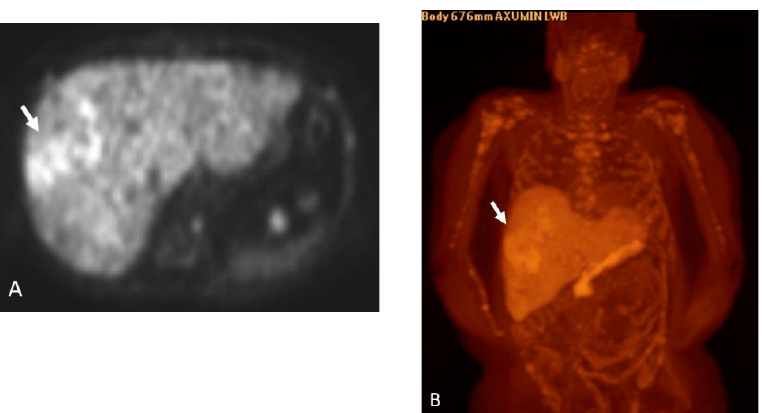
Figure 11. Eighty-year-year-old male with history of prostate cancer, status post-prostatectomy. Axumin PET ( A ) and MIP ( B ) images shows heterogeneous radiotracer uptake in the right hepatic lobe (arrow) concerning for hepatic metastatic disease. Also note the widespread metastatic disease involving the axial and appendicular skeleton.